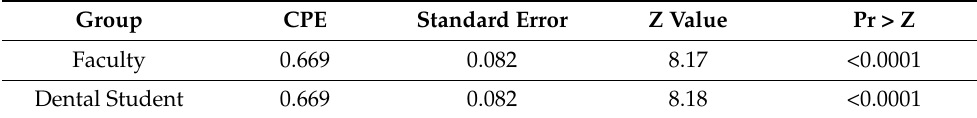
Table 3. Covariance parameter estimate (CPE) for 7-point scale.